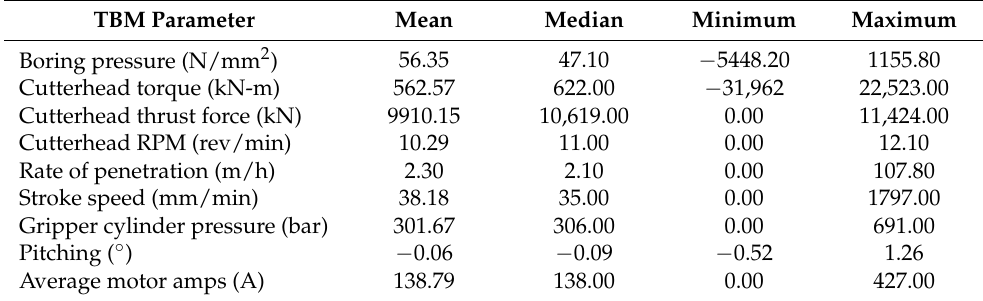
Table 3. Summary statistics of the TBM